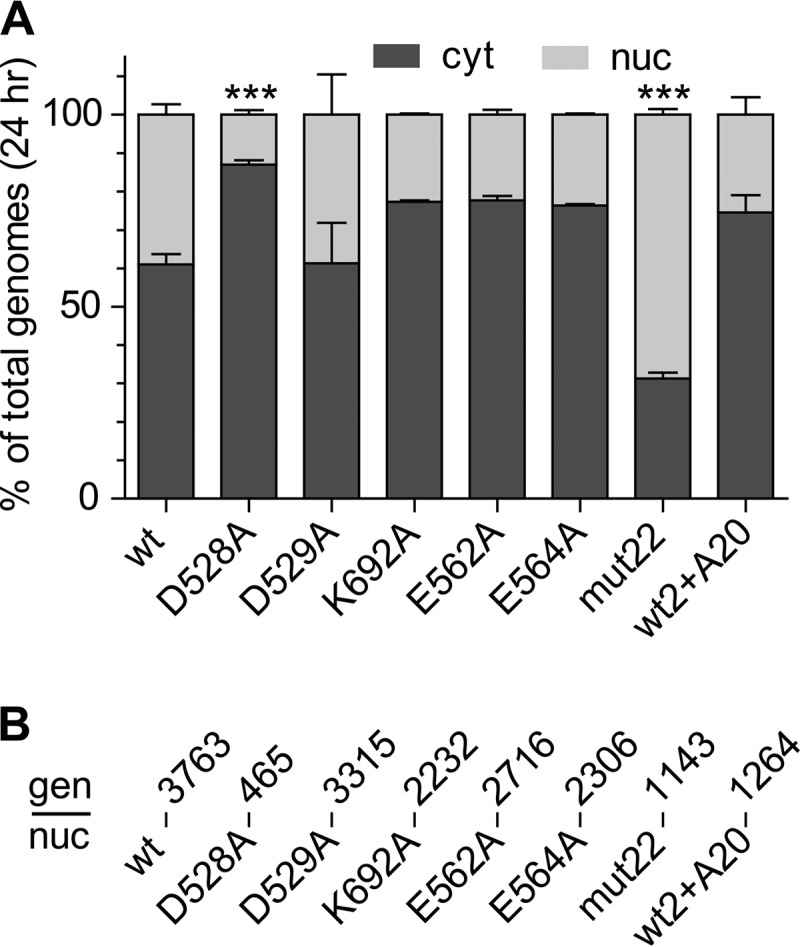
Efficiency of nuclear entry. (A) Percentages of total viral genomes in the cell that entered the nucleus (nuc) by 24 h. Two mutants, D528A and mut22, accumulated significantly lower and higher percentages of genomes, respectively, in the nucleus than the wt, as determined by one-way ANOVA (F[7,17] = 17.37; P < 0.0001; n = 3). Tukey's post hoc comparisons to the wt are indicated (***, P < 0.001). There was no significant difference between the remaining mutants or the A20-bound virus and the wt. cyt, cytoplasm. (B) The number of viral genomes per nucleus (gen/nuc) is indicated for each mutant or the A20-bound wt virus (top row) at 24 h (means of data from three experiments) regardless of variations in cell entry or nuclear accumulation rates.